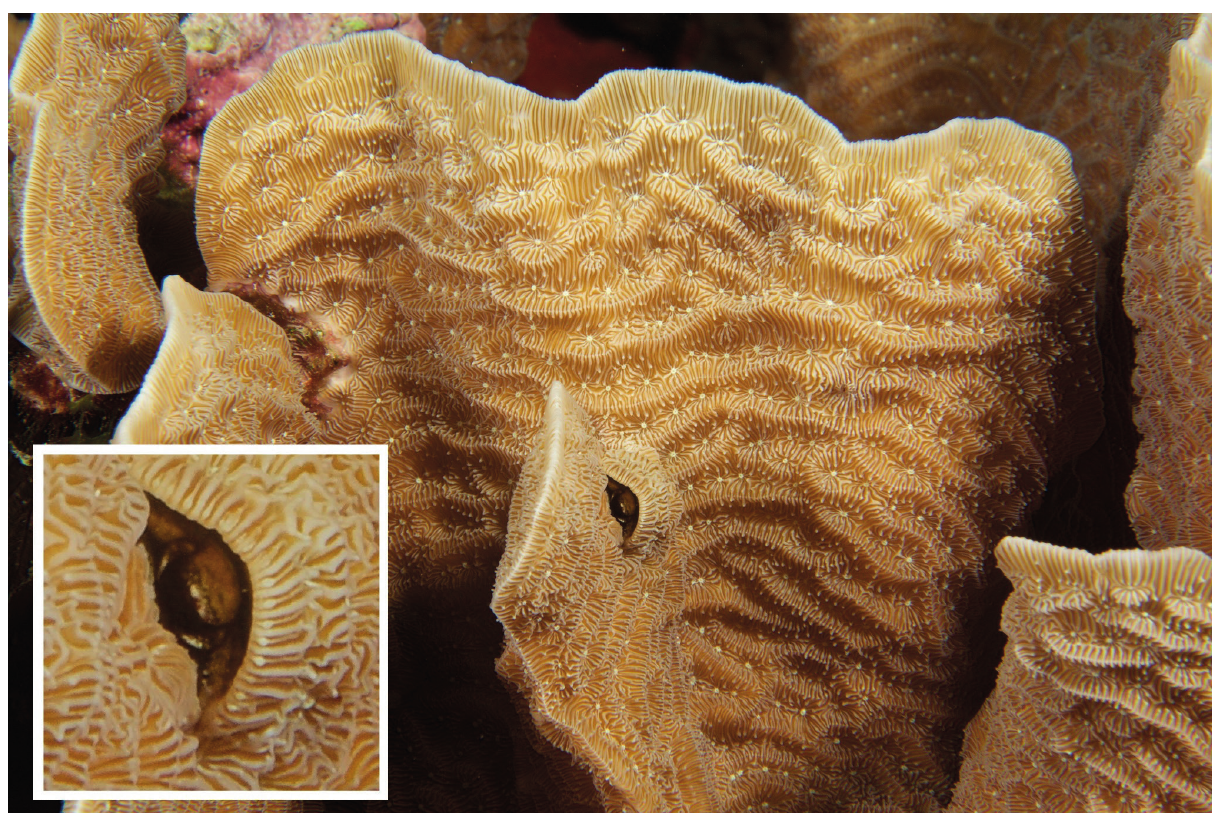
Figure 1. A gall crab, tentatively identified as Opecarcinus hypostegus , in its dwelling (inset) in the scleractinian coral Agaricia tenuifolia at Willemstoren,